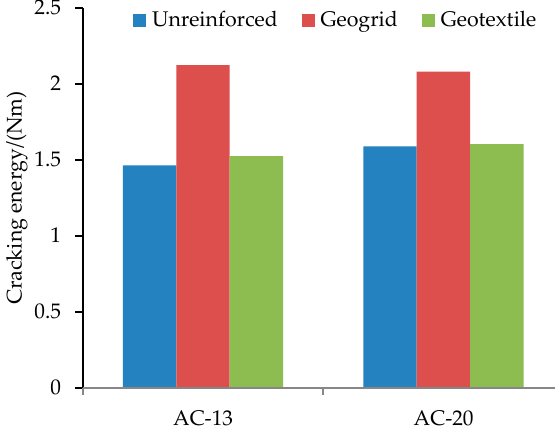
Figure 5. The cracking energy of the six types of asphalt samples.